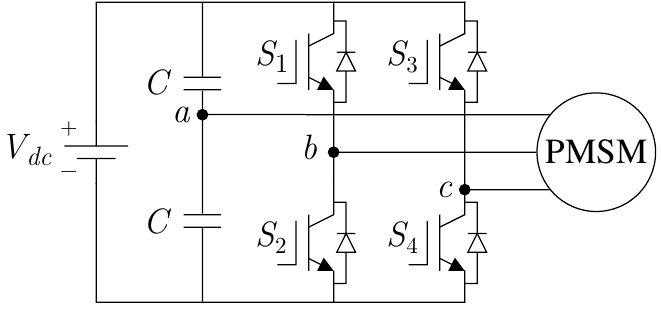
Figure 2. Four-switch three-phase (FSTP) voltage source inverter (VSI) (phase- a is connected to the center tap of the split